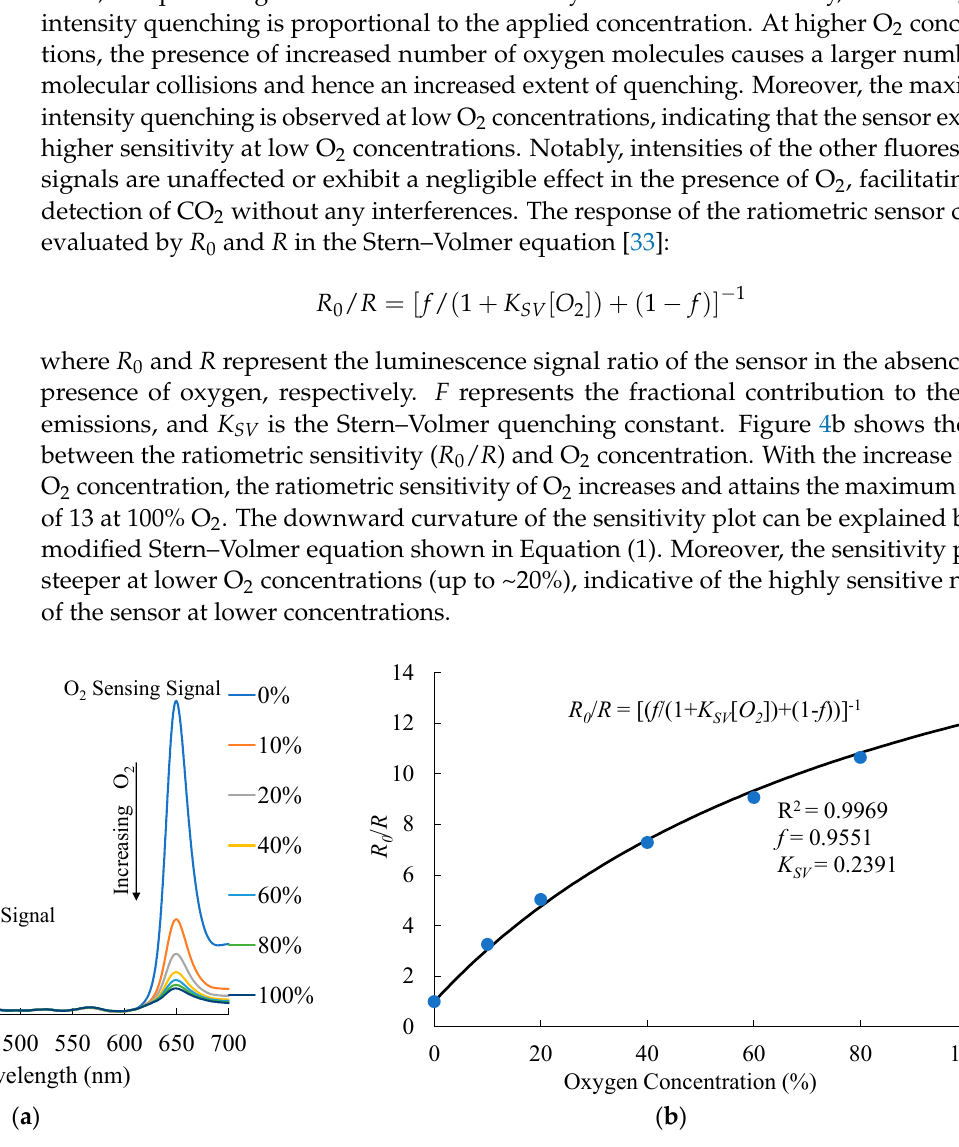
2 concentrations and ( b ) Stern-Volmer